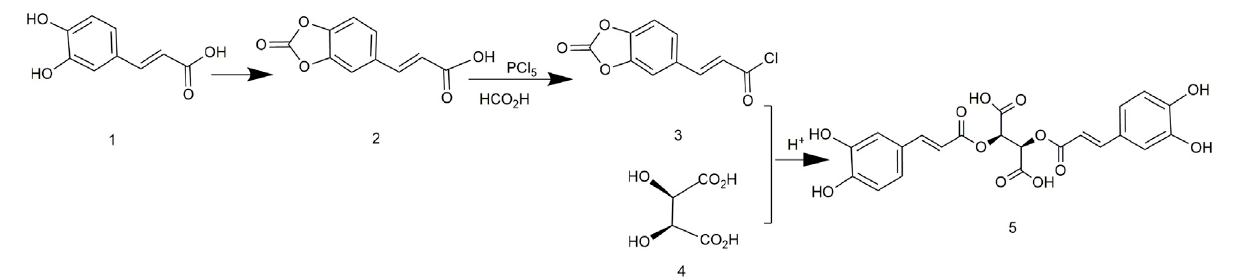
FIGURE 3 | Chemical synthesis pathway 1 of chicoric